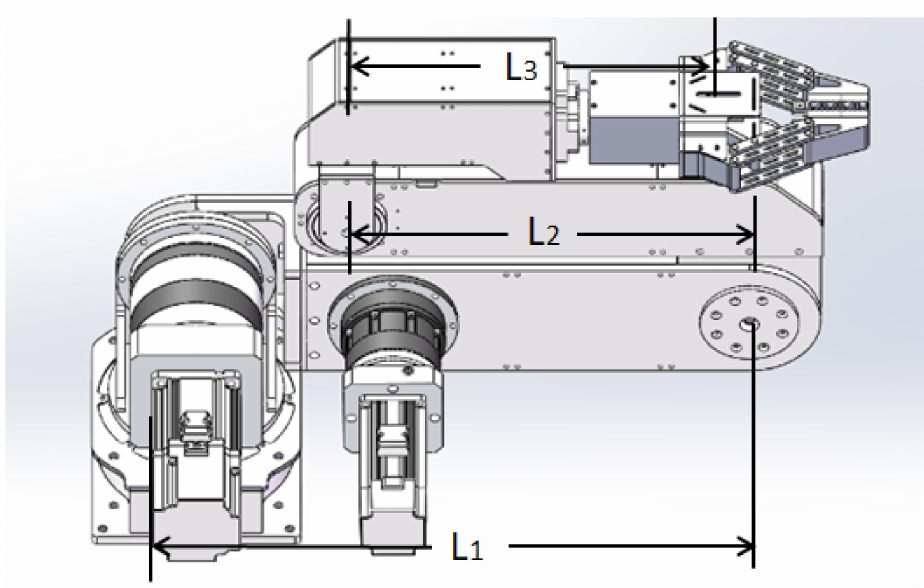
Figure 2. Prototype model diagram of the robot manipulator.